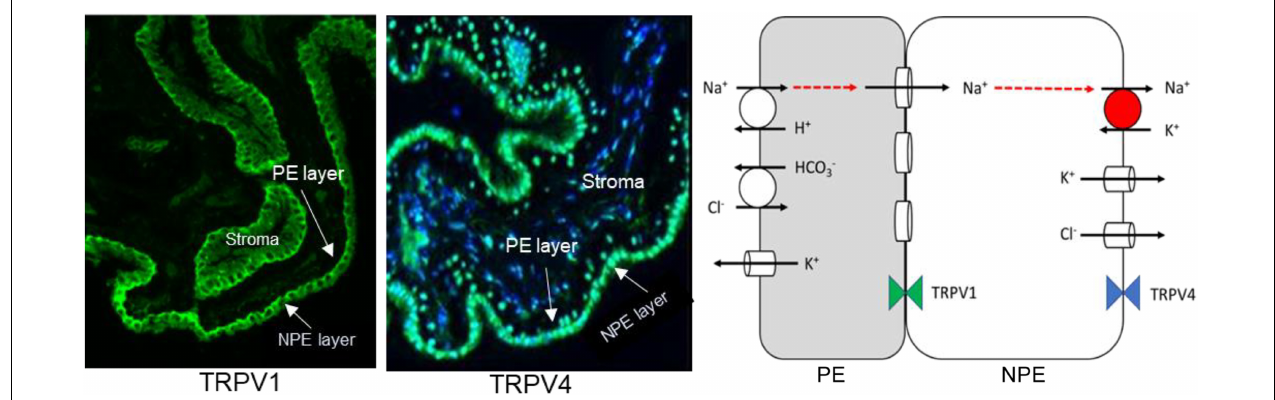
FIGURE 5 | Expression of TRPV1 (Left Panel) and TRPV4 (Middle Panel) in porcine ciliary epithelium. Immunolocalization was carried out on paraffin sections as described previously (Shahidullah and Delamere, 2014). The scheme on the right depicts the localization of transport mechanisms that contribute to transepithelial solute and water movement that supports aqueous humor formation. It is adapted from Charles W. McLaughlin et al. (McLaughlin et al., 2004). The model has been simplified for clarity. Aqueous humor flow occurs in the PE-to-NPE direction. The PE and NPE are coupled by gap junctions and function in the manner of a syncytium. Na, K-ATPase activity is highest at the basolateral, aqueous humor-facing, surface of the NPE. In respect to coupling and Na, K-ATPase distribution, the tissue is similar to the two-cell model shown in Figure 1